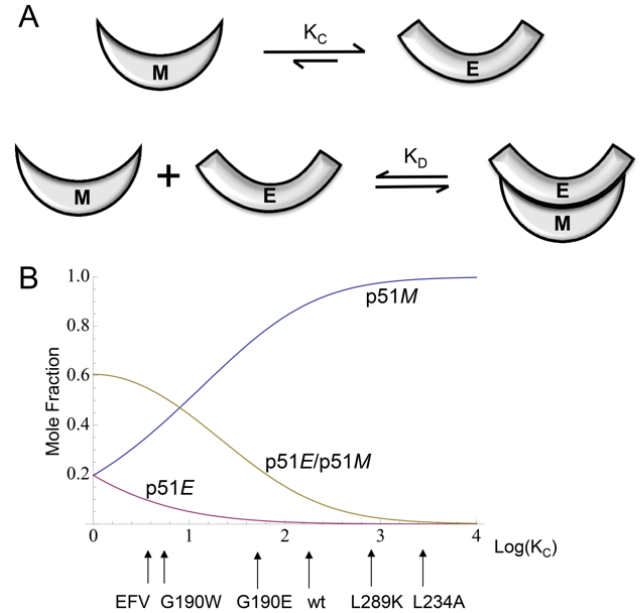
Figure 13. Conformational equilibria of the polymerase domain. ( A ) Schematic illustration of the two steps—domain rearrangement followed by monomer–monomer binding, required for homodimer formation. Formation of the initial dimer is proposed to involve a pair of molecules in the E and M conformations; ( B ) Calculated mole fractions of monomer and dimer species plotted as a function of Log[K C ] for parameters K D = 2.0 µM and total monomer concentration of 50 µM. Qualitative effects of the NNRTI efavirenz (EFV) and of several mutations that influence K C and indirectly alter the apparent dimer stability are indicated on the horizontal axis. E and M represent the extended and monomeric conformations of the polymerase domain (based on Figure 9 of [25]).